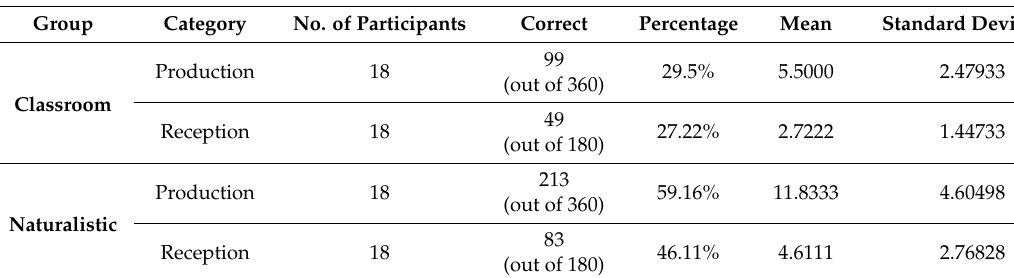
Table 3. Mean Scores for Productive and Receptive Tests of the Two Groups.